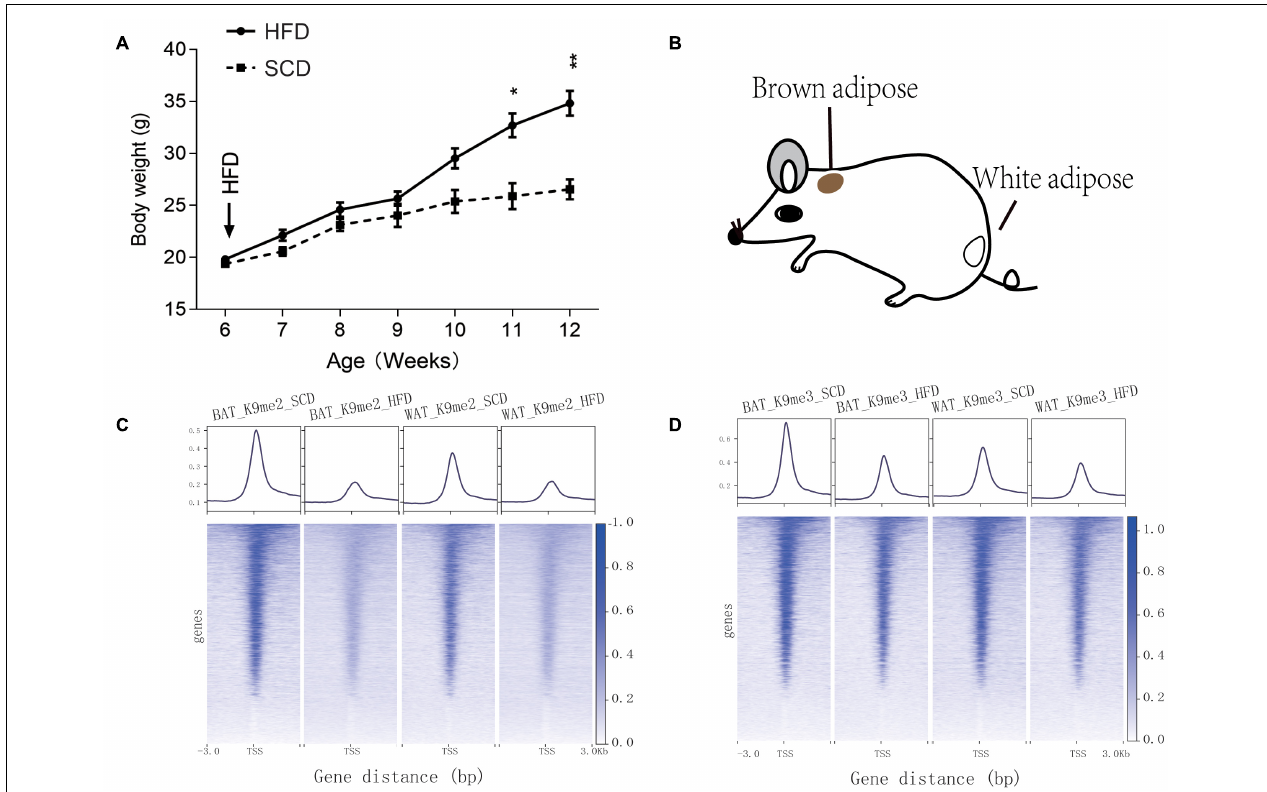
FIGURE 1 | Information of SCD and HFD mice used in this study and peak enrichment of H3K9 methylation. (A) Body weight monitoring of mice under control (SCD) and high fat diet (HFD) treatments. * P < 0.05, ** P < 0.01. (B) Dissection location of mouse brown adipose tissue and white adipose tissue used for the H3K9me2 and H3K9me3 ChIP-seq experiments. (C,D) Peak enrichment at histone H3K9 methylation modification (H3K9me2 and H3K9me3) near the transcription start site (TSS, ± 3 kb) of